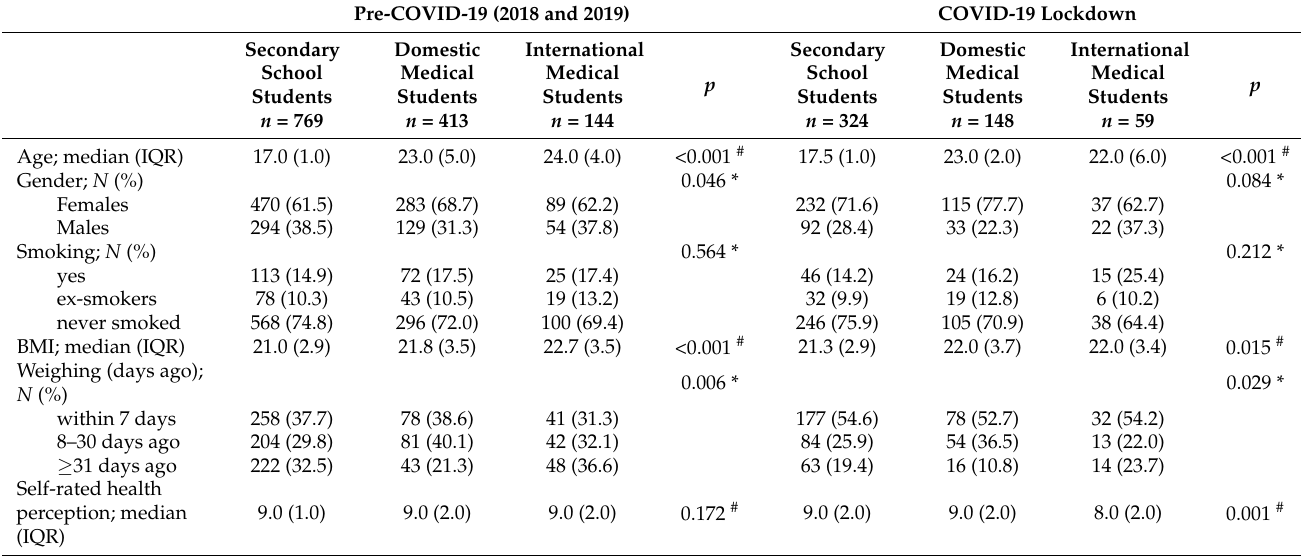
Table 1. General characteristics of the sample before and during COVID-19